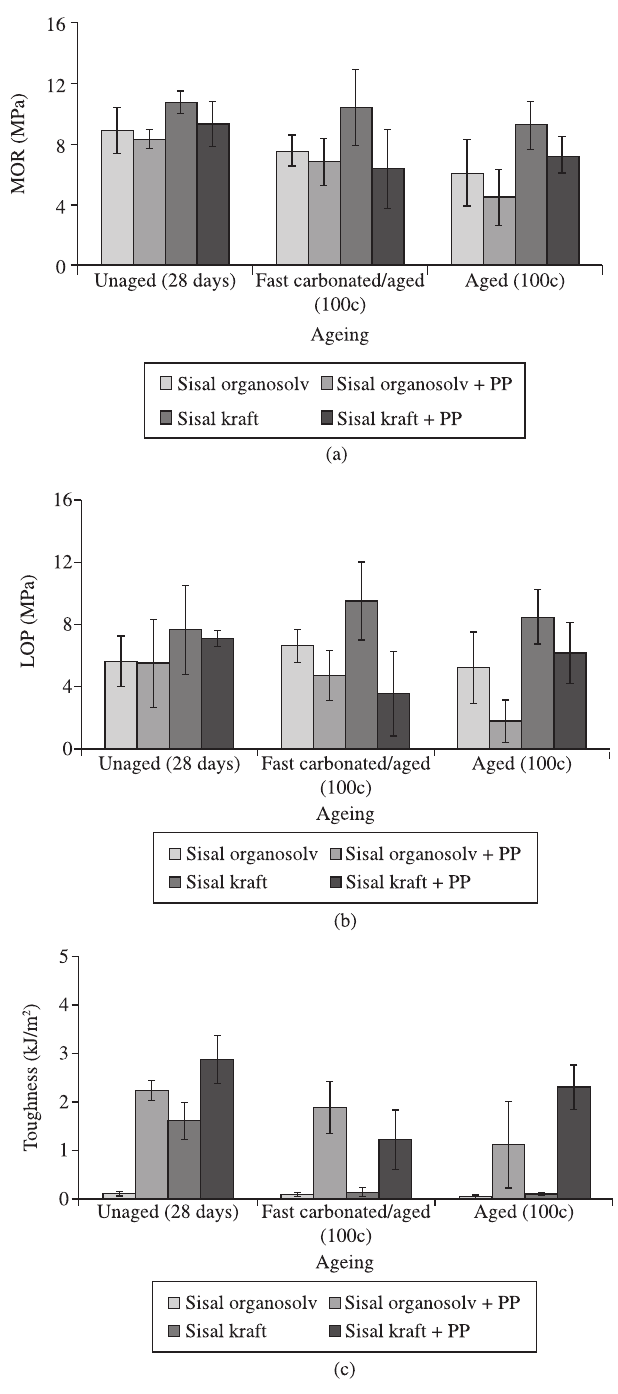
Figure 5. Physical properties of the composites reinforced with sisal orga- nosolv and PP fibres at 28 days, fast carbonated/aged and aged. a) Water absorption, b) apparent void volume and c) bulk density.